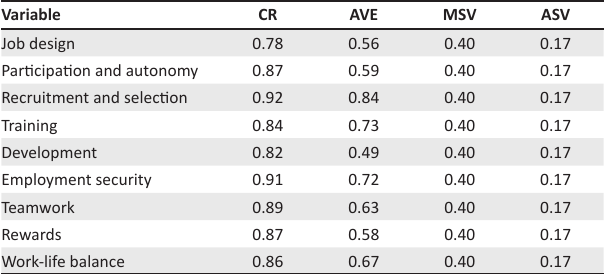
TABLE 7: Convergent and discriminant validity of the HRPPQ (adapted structural configuration)